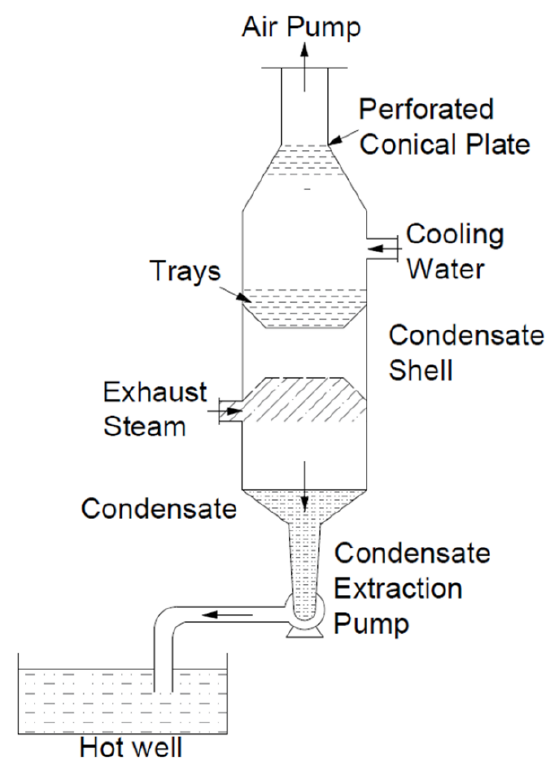
Figure 3. Low-level counter-flow jet type condenser.